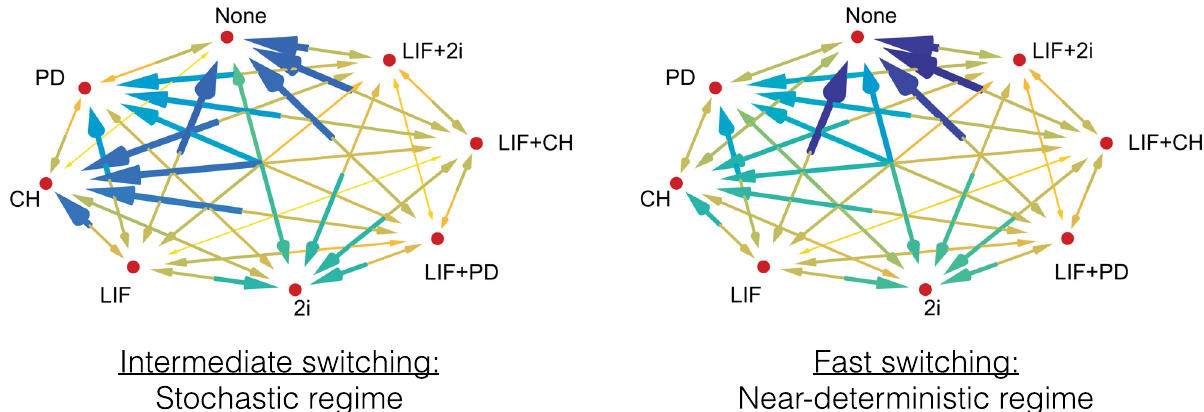
Fig 6. Transition times between the stationary distributions of different external conditions. A larger, darker arrow indicates that a given transition takes a longer time to converge to its stationary state. This time scale is measured by simulating a large ensemble (10 5 ) of PDMP sample paths to provide a simulated probability density and finding the Jensen–Shannon divergence [69, 70] between the instantaneous distribution of each TF and its final stationary distribution. The time for the each divergence to fall below a threshold ( ≔ 0.3) is recorded, and we choose the largest of these as a quantification of the transition time. The numerical values can be found in S1 and S2 Tables in the Supporting Information.